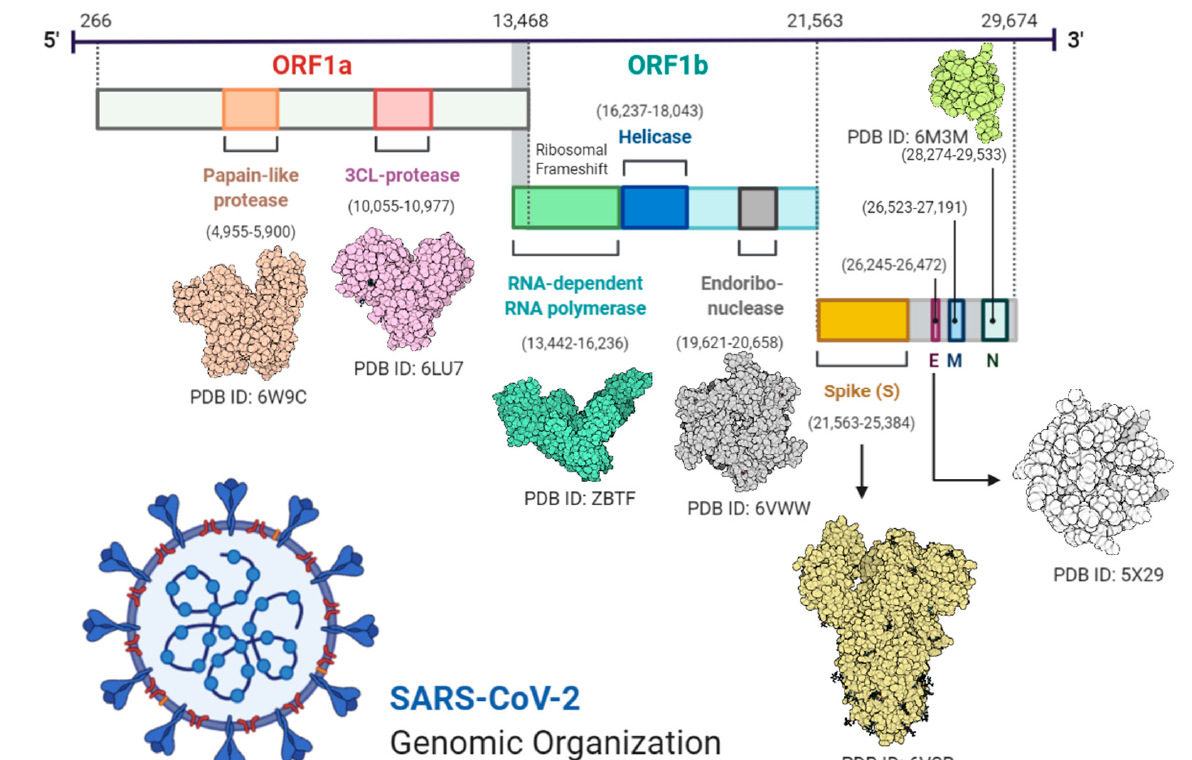
Figure 1. Complete structural and genomic organization of severe acute respiratory syndrome coronavirus 2 (SARS-CoV-2) [23].